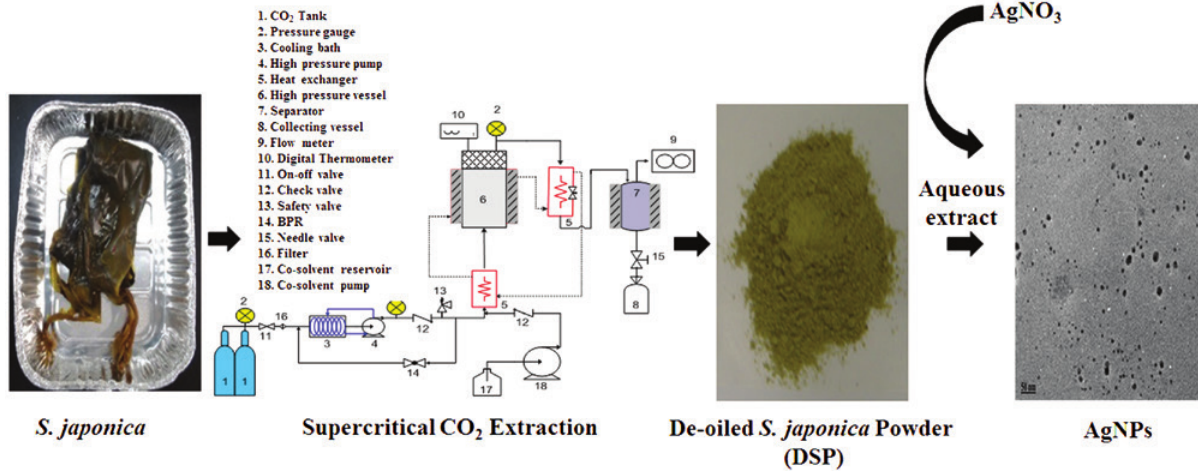
Figure 1: Schematic drawing of green synthesis diagram of